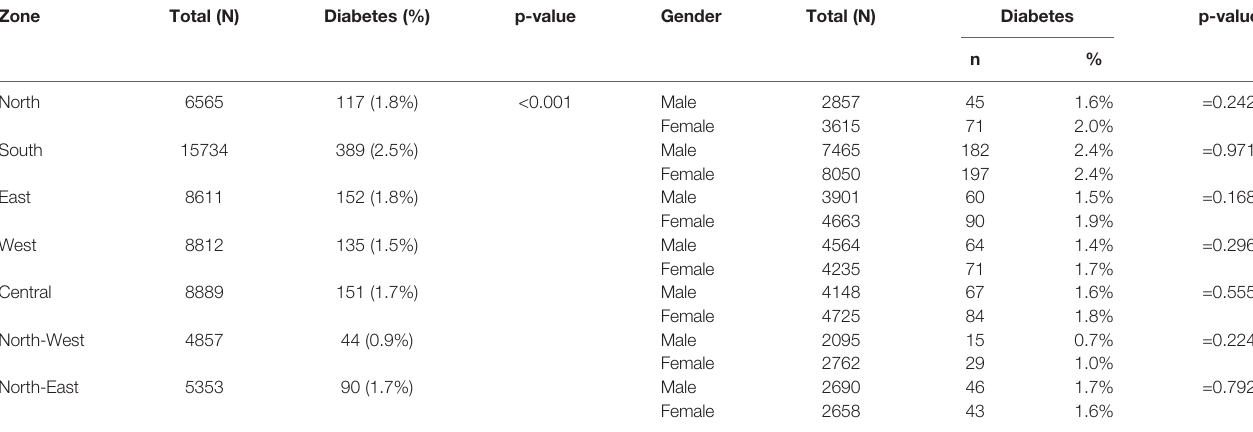
TABLE 2 | Zone-wise frequency distribution of self-reported diabetes participants.